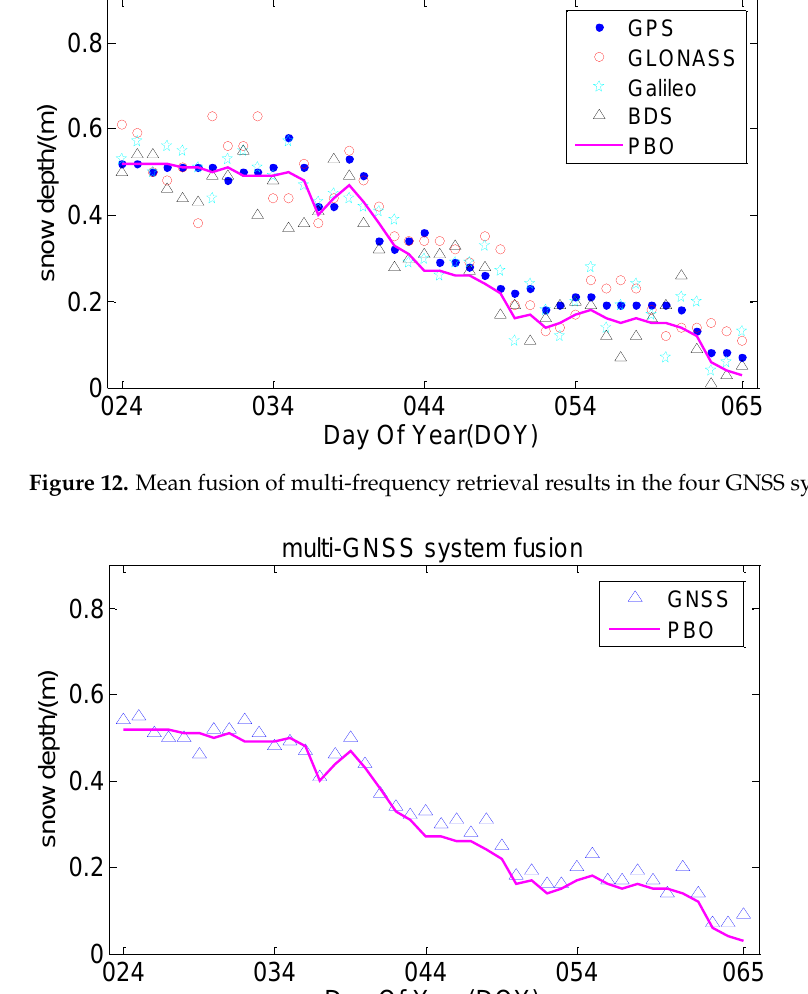
Figure 12. Mean fusion of multi-frequency retrieval results in the four GNSS systems.